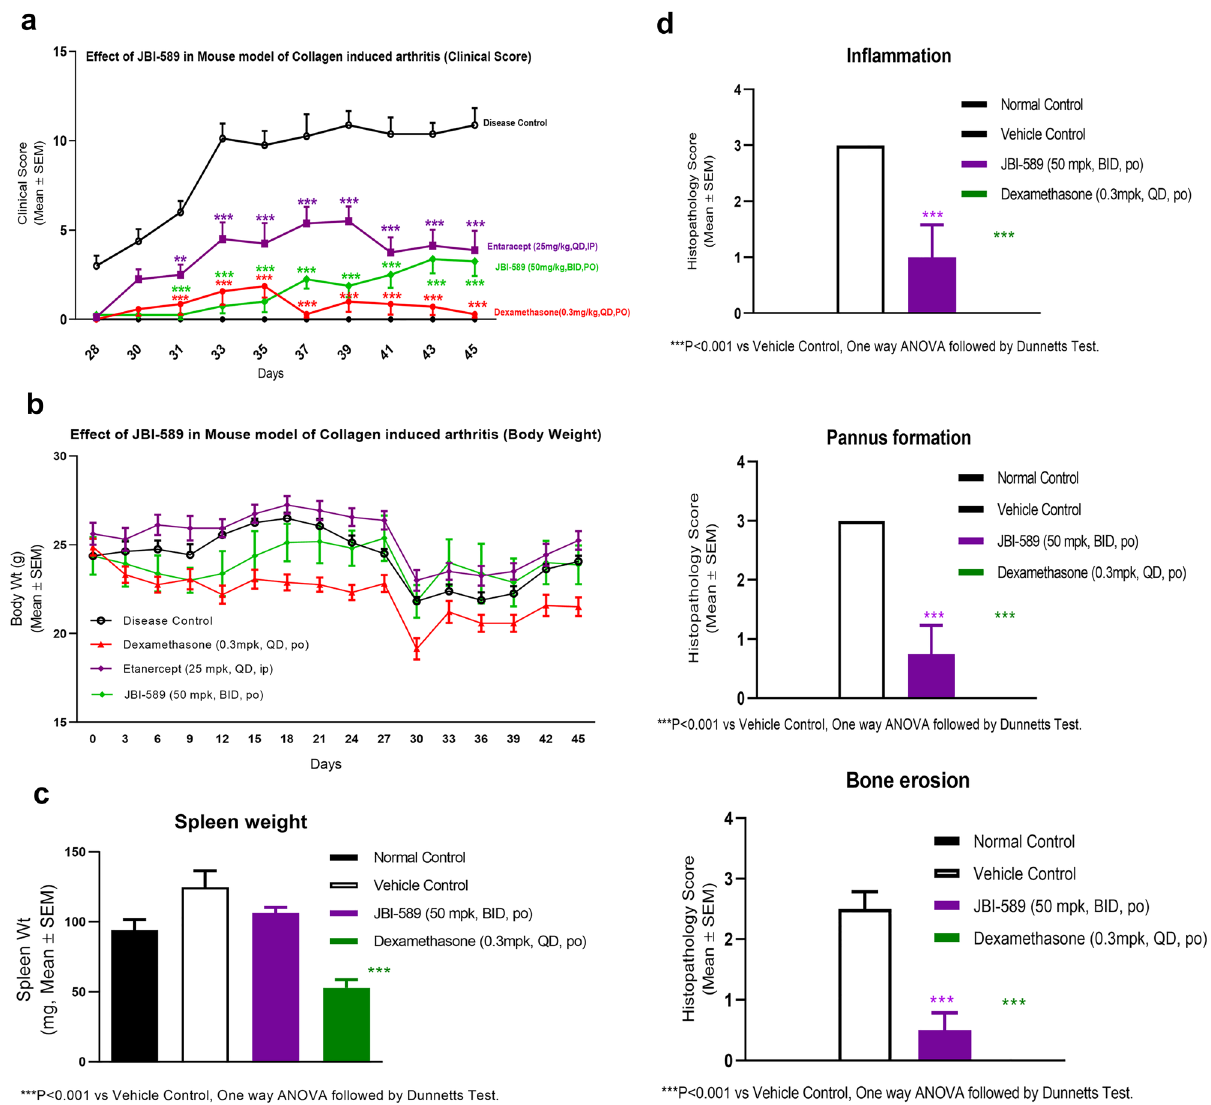
Figure 4. Effect of JBI-589 in the collagen-induce arthritis model in DBA/1 mice. Mice were dosed with either vehicle control (0.5% methyl cellulose + 0.05% tween 80) or JBI-589 at 50 mg/kg, PO twice daily from day 0 until day 45. Etanercept was administered at 25 mg/kg, IP from day 31–45. ( a ) Clinical score of mice from day 28 to day 45 ( b ). Body weight of mice from day 0 to day 45 ( c ). Effect of various treatments on spleen weight of mice on day 45 d. Histological scores determined by H&E staining in the paws of arthritic mice measuring inflammation, pannus formation and bone